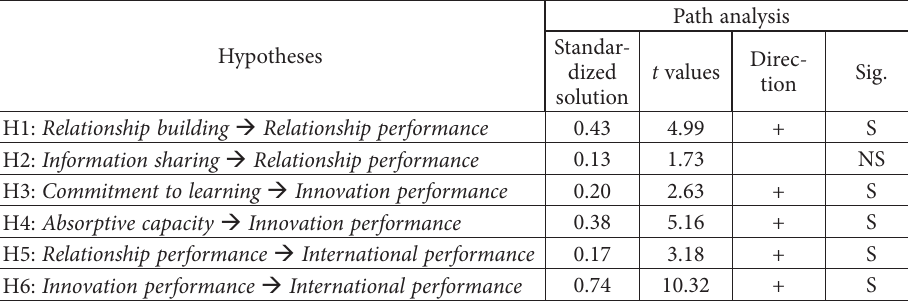
Table 6. Hypotheses test results using SEM analysis